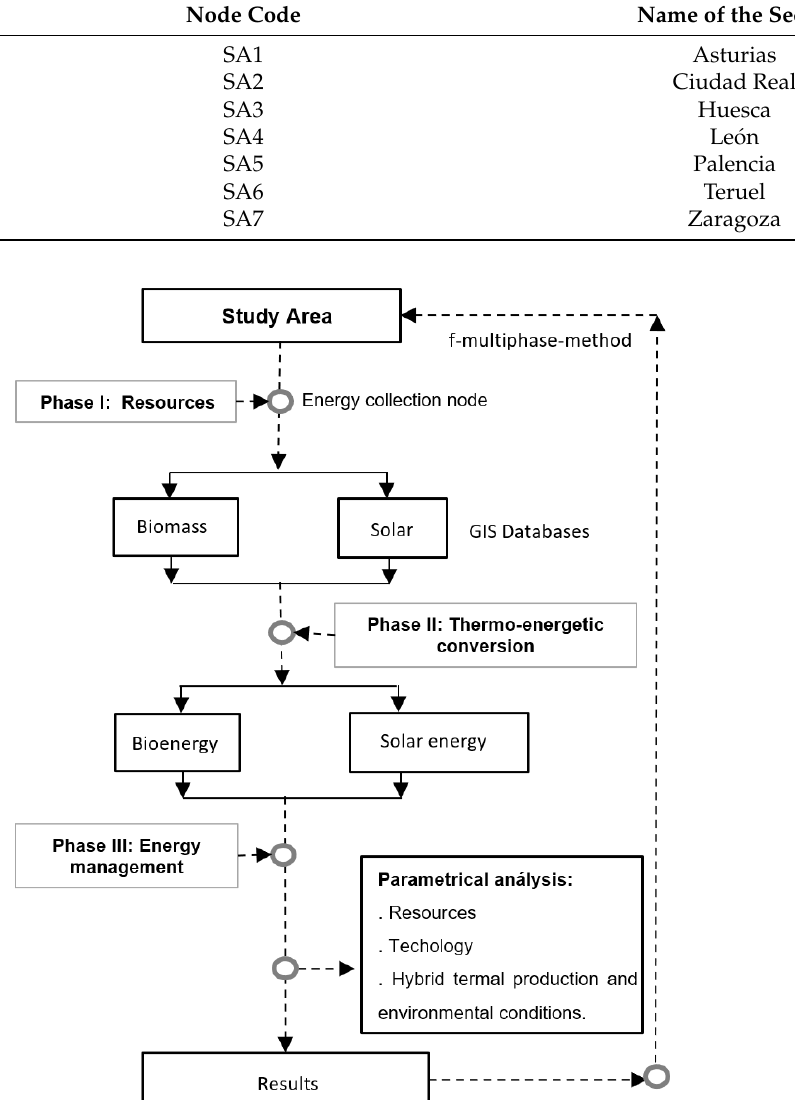
Table 1. Definition of the node code and the sectors in the study area, as Figure 1.